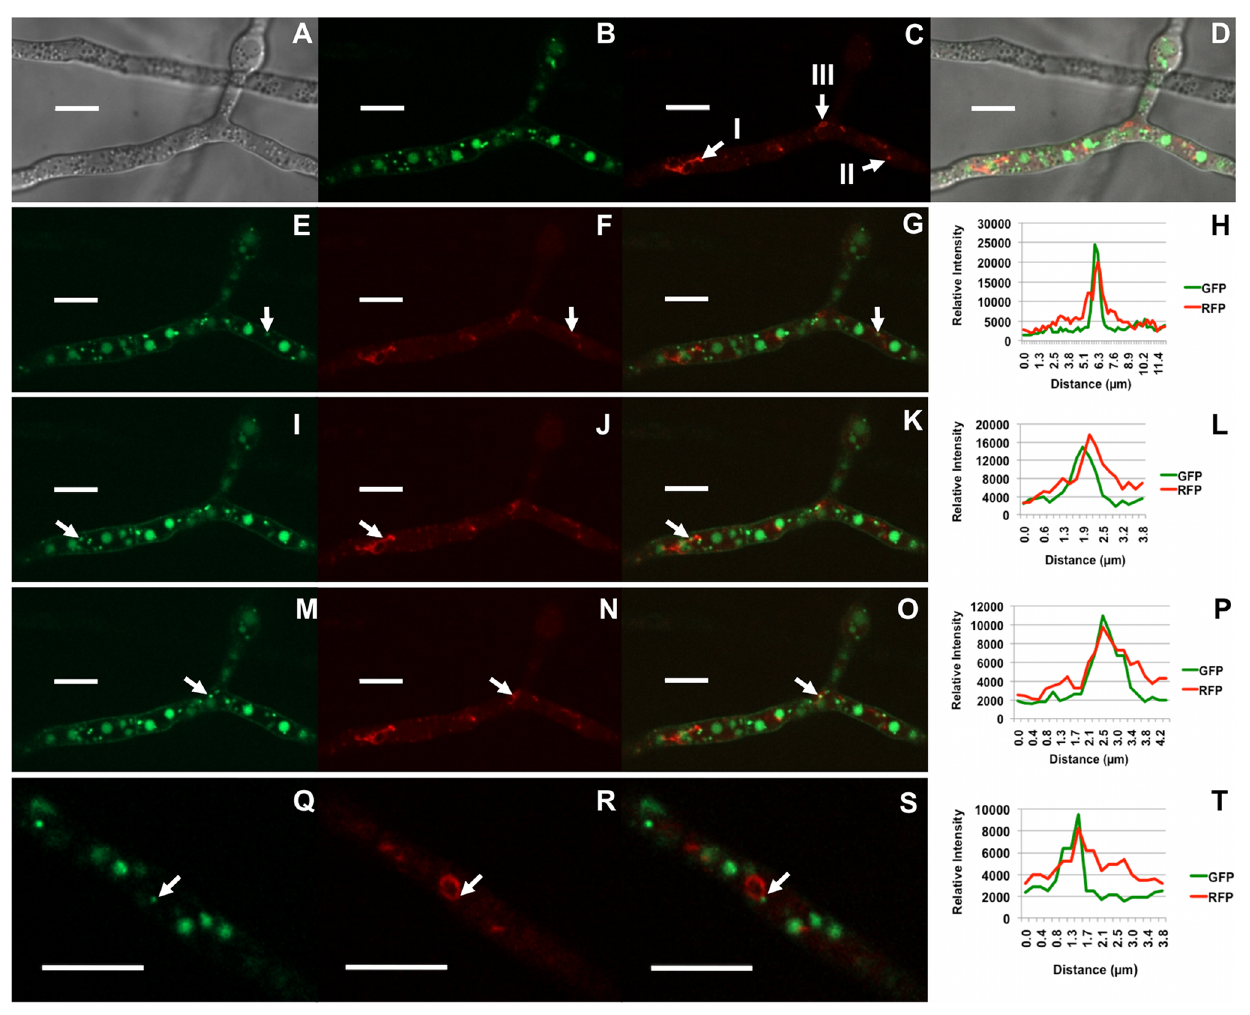
Figure 4. Close associations between Tri12p::GFP labeled vesicles and F-actin. Strain PH-1Tri12::GFP/Lifeact::RFP co-expressing Lifeact::RFP and Tri12p::GFP fusion proteins 36 h after suspension in TBI medium. Confocal bright field DIC (A), GFP (B, E, I, M, Q); RFP (C, F, J, N, R); DIC, GFP and RFP overlay (D); and GFP and RFP overlay images (G, K, O, S) are shown. Arrows in image C identify actin cables (I), an actin patch (II) and a lariat-like structure (III) composed of actin cables. Signal intensity of GFP and RFP emission spectra (H, L, P, T) were generated from a line bisecting the organelles labeled (arrows) in images E–G, I–K, M–O and Q–S. Panels E–G, I–K and M–O are images of the same culture at different times shown in Video S3. Panels Q–S are from a separate cell image captured from Video